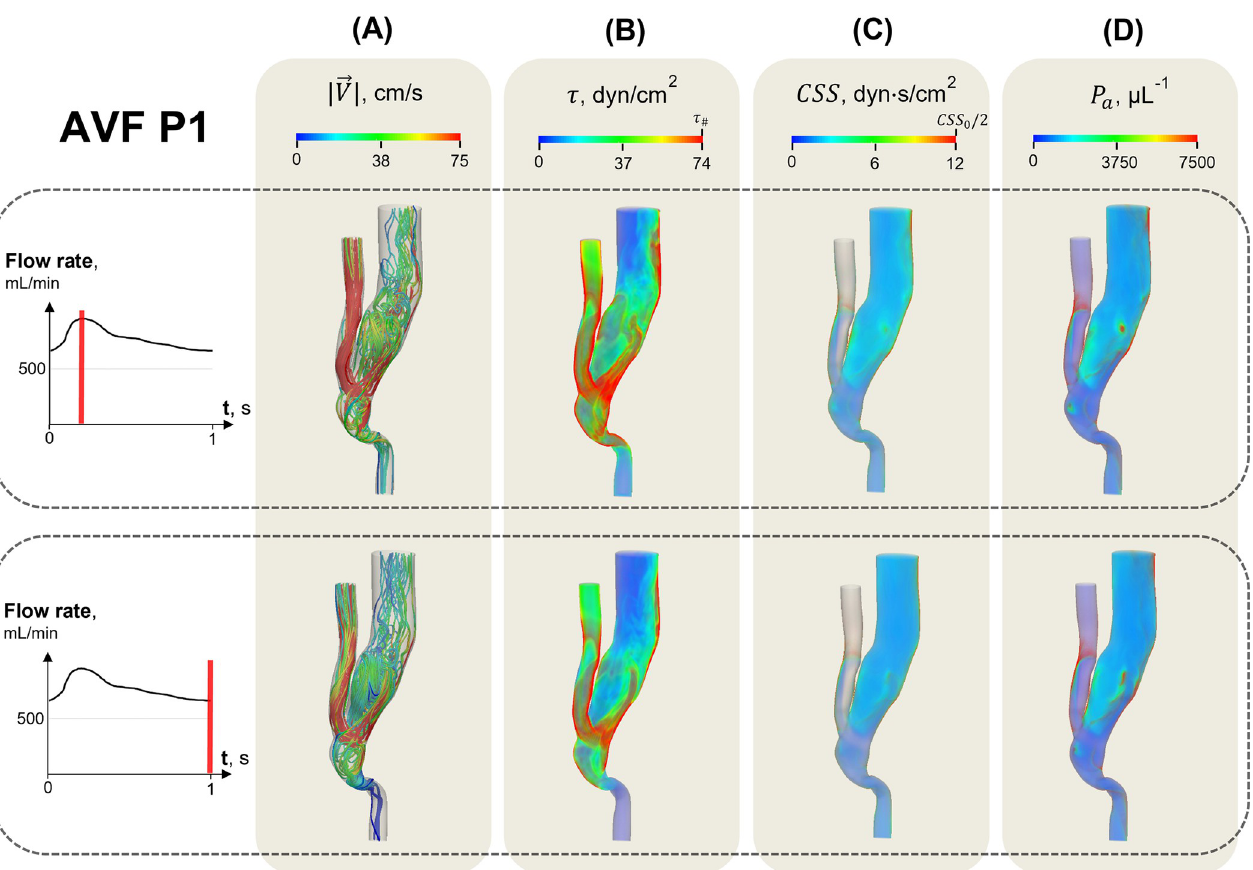
�� ! | (A), shear = 725 mL/min, N = 100). The blue out